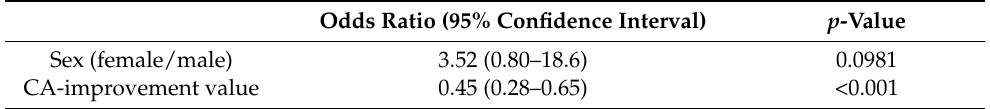
Figure 6. Initial and second evaluation CA values of infants with plagiocephaly in the natural-course and CHT groups. CHT, cranial helmet therapy. Table 4. Multivariate statistical